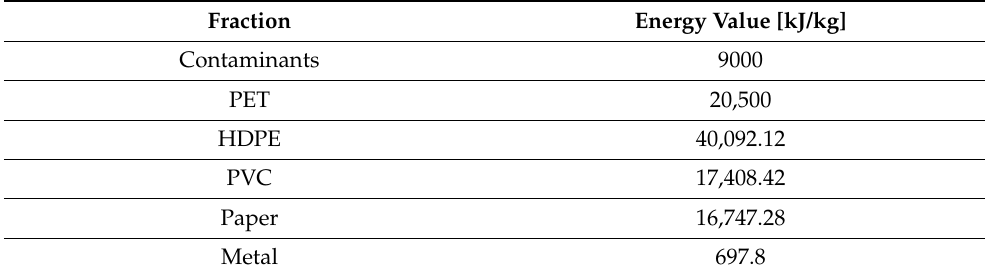
Table 6. Values of the individual linguistic variables.